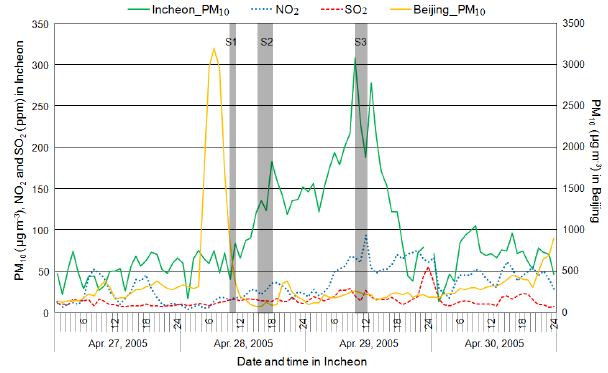
Fig. 1. Satellite images recorded (a) at 11:50 Korea Standard Time (KST) on 28 April 2005; (b) at 18:55KST on 28 April 2005; and (c) at 11:45KST on 29 April 2005 (provided by NOAA). 25 m a.g.l.) at Inha University (37.45 ◦ N, 126.73 ◦ E), In-